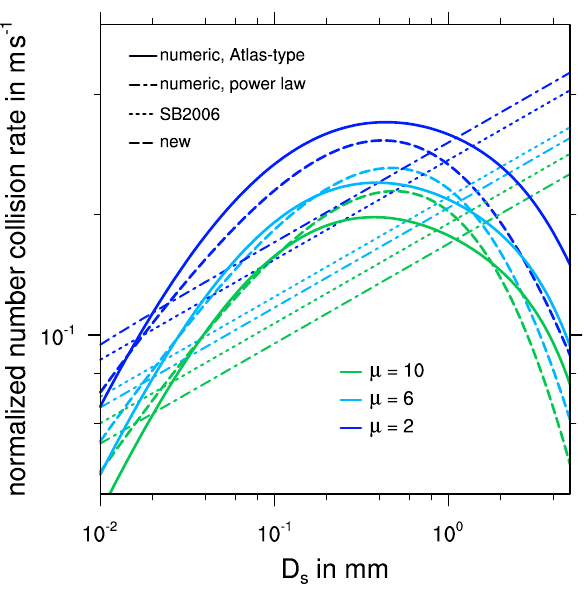
Fig. 8. Normalized bulk number collision rate in m s − 1 for the self-collection of snow as a function of the mean maximum diam- eter of snowflakes. Shown are the results for three different values of the gamma shape parameter, µ s = 2, µ s = 6 and µ s = 10, for the SB2006 approximation (dotted), the revised variance approxi- mation using the Atlas-type terminal fall velocity (dashed) and the numerical solution of the integral with Atlas-type (solid) and power- law (dash-dotted) fall